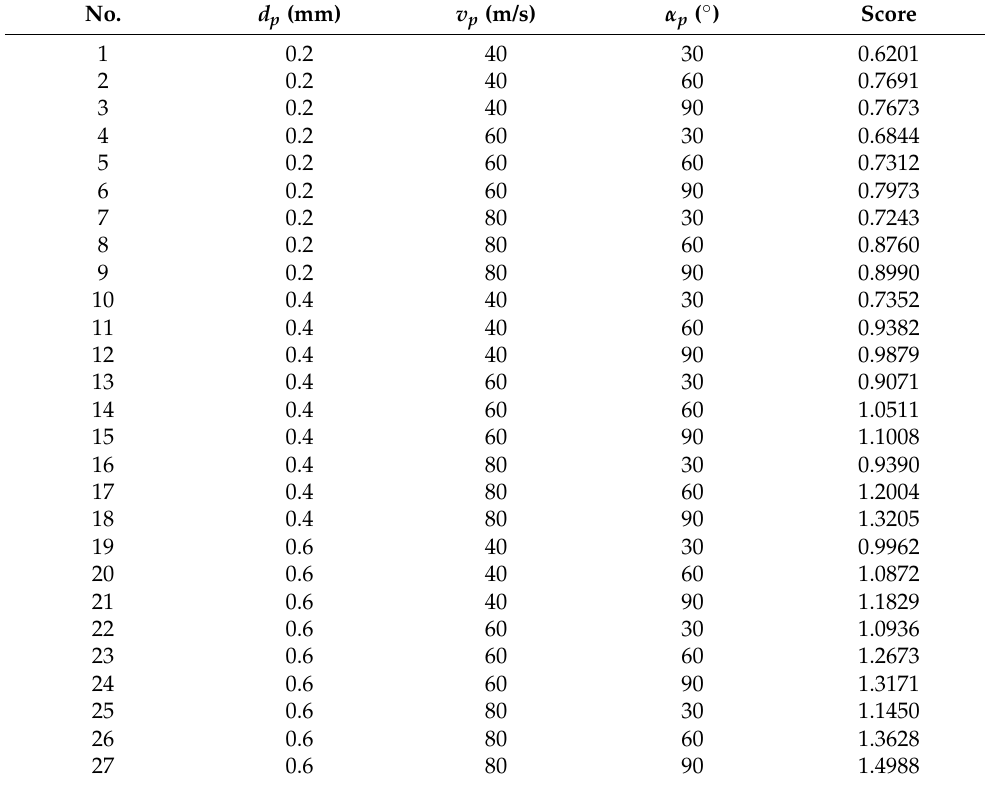
Table 5. Scores from the entropy method.